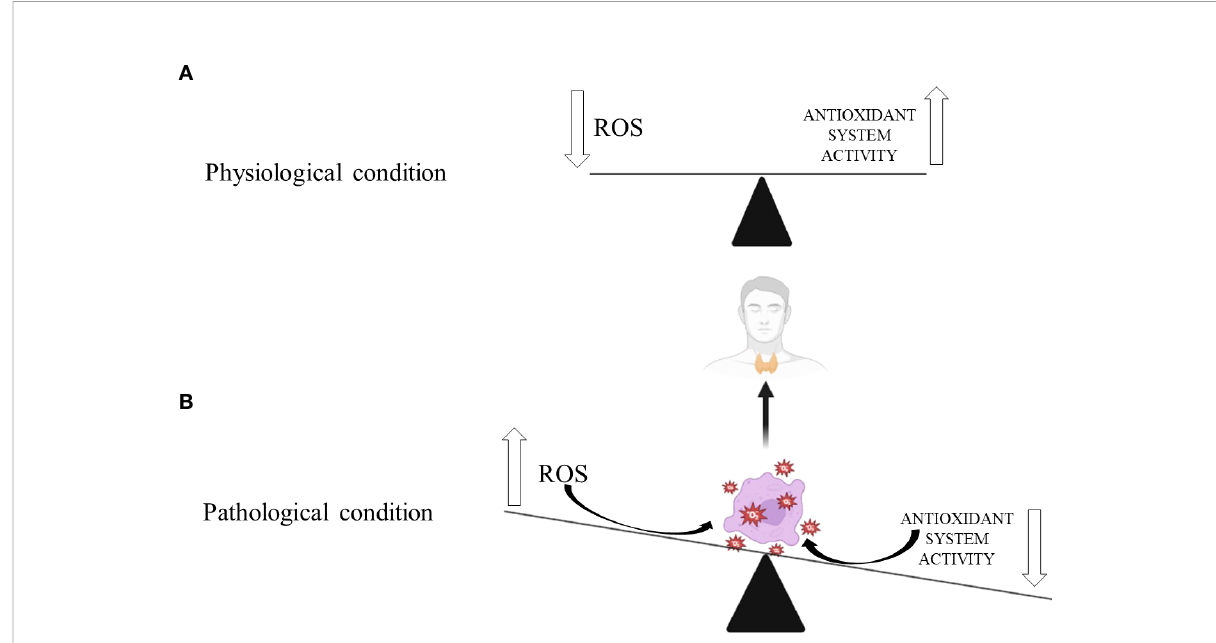
FIGURE 1 Thyroid gland ’ s response to oxidative stress in: (A) physiological and (B) pathological conditions. Biorender.com was used to generate part of the